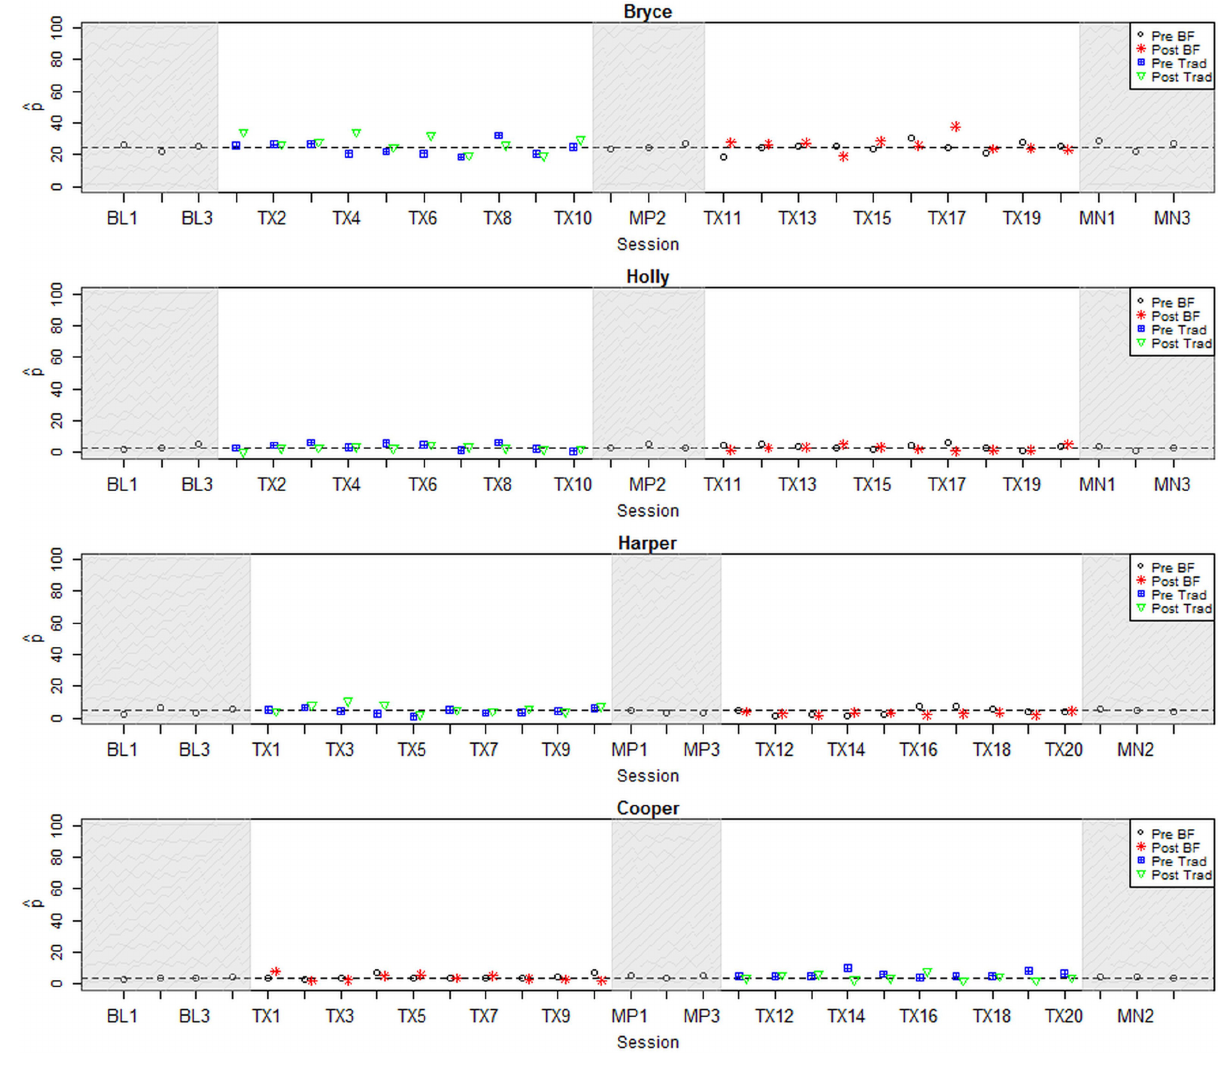
FIGURE 4 | Longitudinal plots of ˆ p correct for participants with null or negative effect size. Dashed line represents mean across baseline sessions. BL, Baseline; Tx, Treatment; MN, Maintenance; BF, Biofeedback; Trad, Traditional.